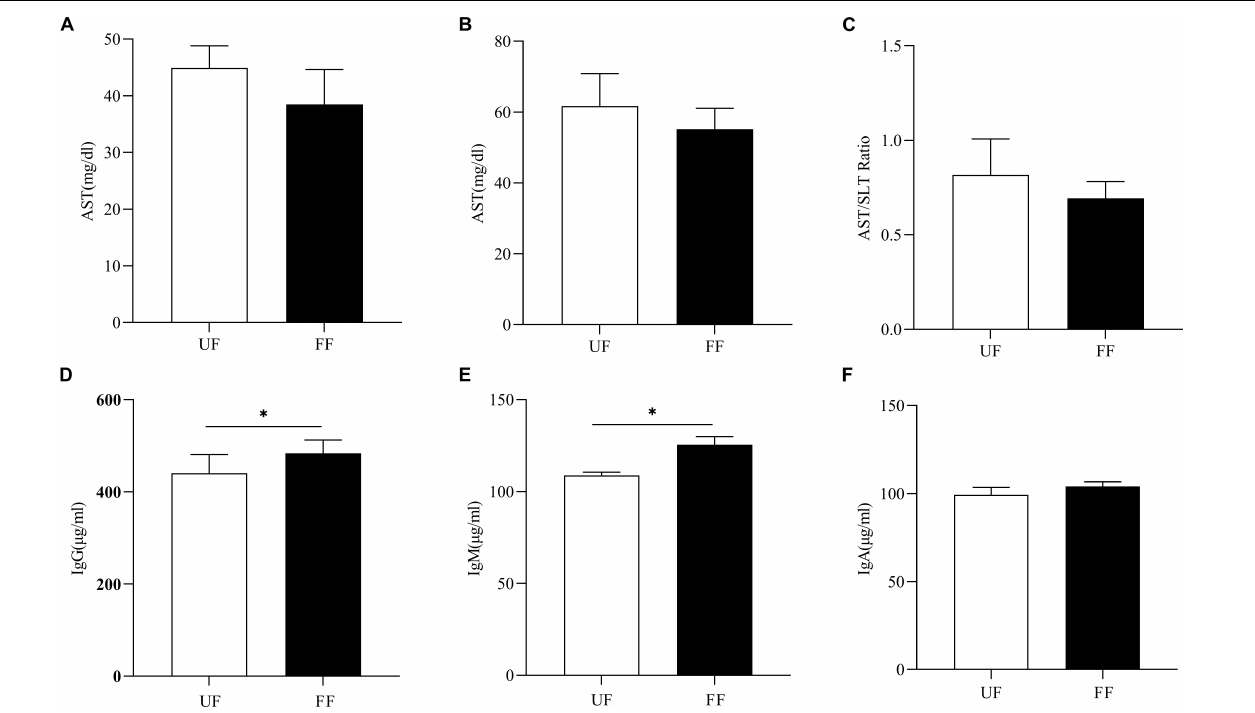
FIGURE 1 | FF changed serum immunity. (A) AST, (B) ALT, (C) AST/ALT ratio, (D–F) . Serum immunoglobulins, IgM (D) , IgA (E) , and IgG (F) . UF, pigs fed with unfermented corn-soybean meal; FF, pigs fed with fermented corn-soybean meal. ∗ P < 0.05.